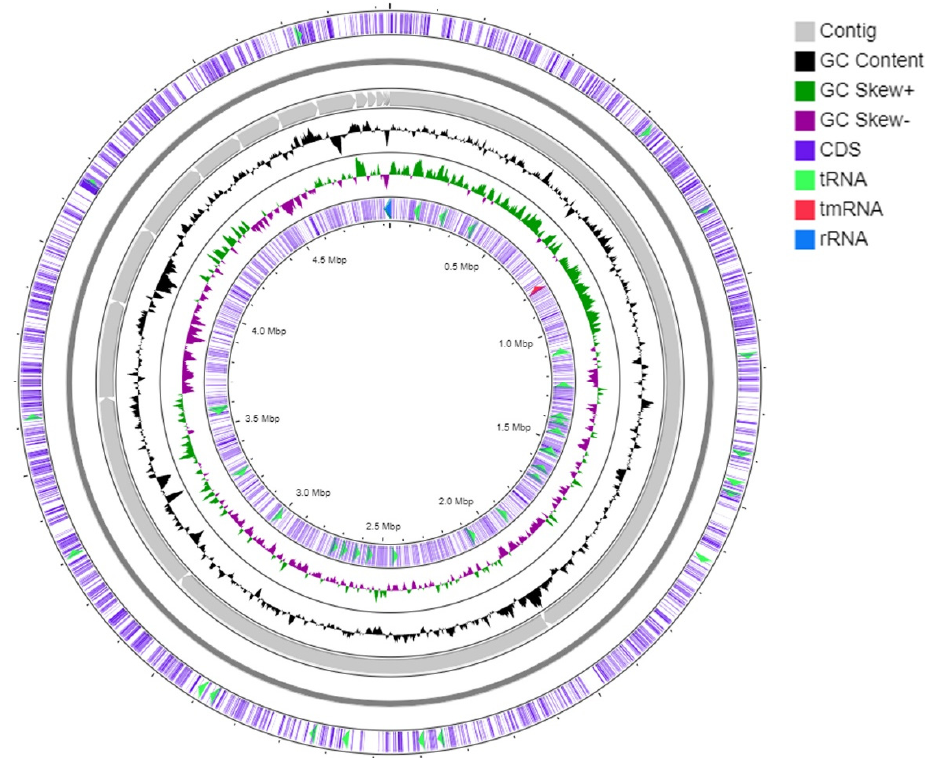
Figure 3. Graphical genome map of strain S-51 T . RNA genes (tRNAs light green, rRNAs blue, tmRNA red), GC content, and GC skew.